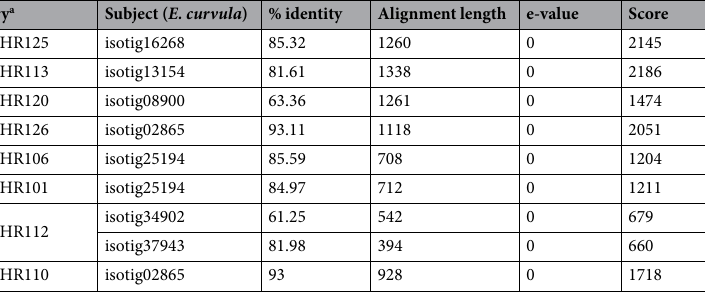
Table 3. Members of the SNF2 super family queried against the Eragrostis curvula protein prediction databases. a Query names as described by 14